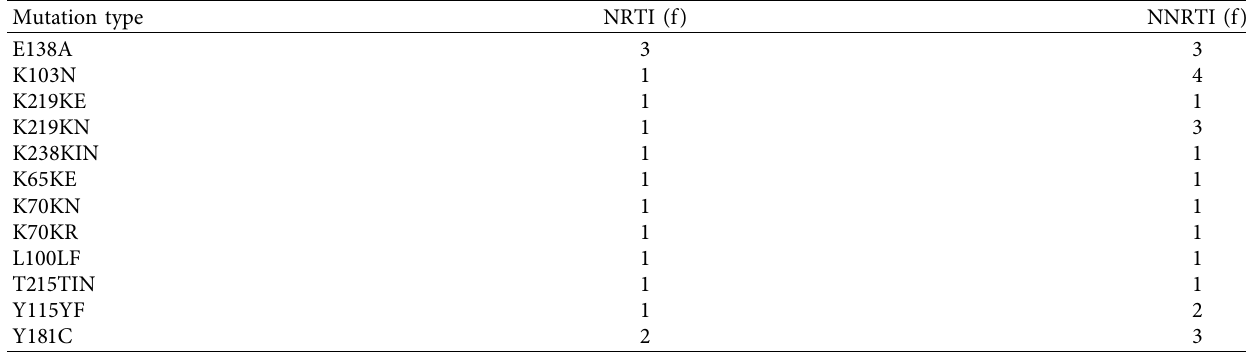
Table 3: Mutations affecting both NRTI and